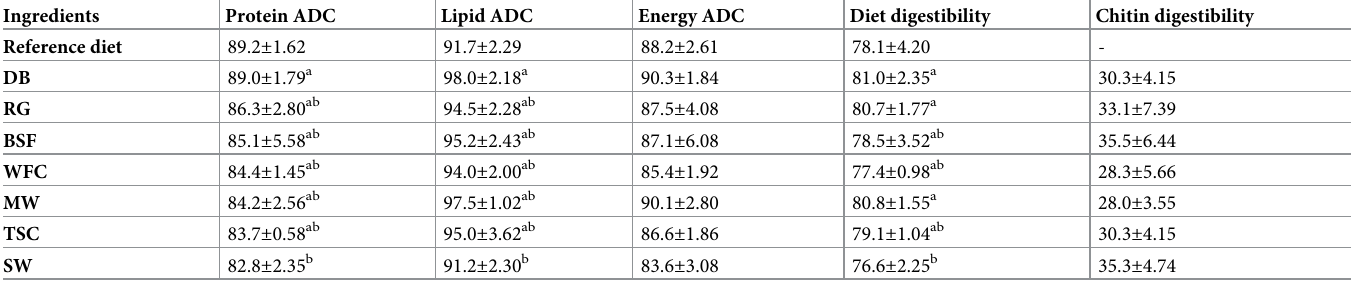
Table 5. Apparent digestibility coefficients (ADCs, %) of protein, lipid, energy, dry matter and chitin in the reference and insect meals for Pacific white shrimp ( Litopenaeus vannamei ). Ingredients